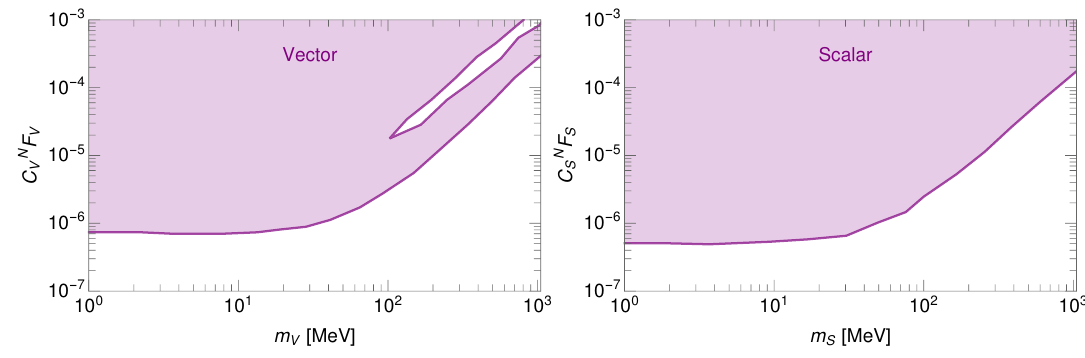
Figure 1 . Left graph : 90% CL limits on vector couplings for light vector mediator scenarios from COHERENT data assuming an energy (cid:13)at quenching factor [9], using spectral and time information and derived through a likelihood analysis. Right graph : same as left graph but for